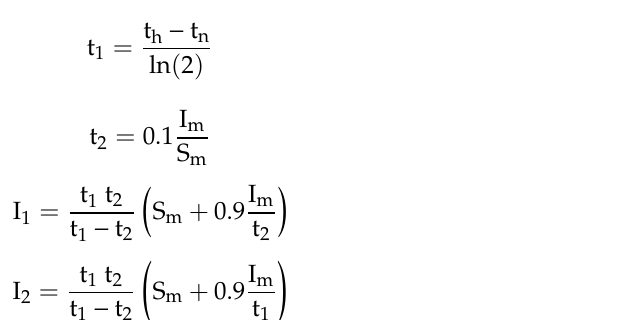
Appl. Sci. 2020 , 10 , x FOR PEER REVIEW Figure 2.